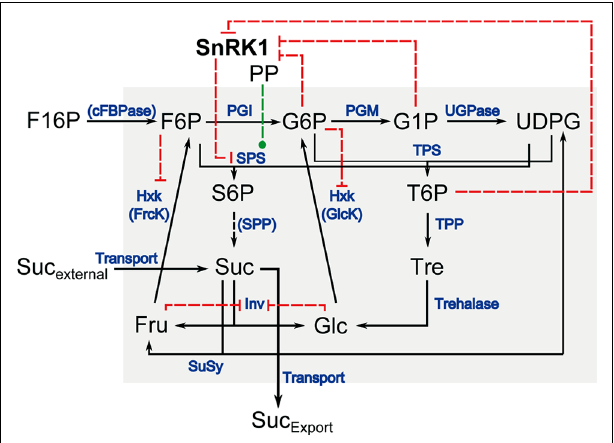
FIGURE 1 | Schematic overview of the cytosolic carbohydrate metabolism in Arabidopsis . Enzymatic interconversions are indicated in black arrows, enzymes that catalyze each step are written in blue. Red dashed lines indicate inhibitory interaction, green dashed lines indicate activation. SnRK1: Snf1-related protein kinase 1; PP: protein phosphatase; F16P: fructose-1,6-bisphosphate; F6P: fructose-6-phosphate; G6P: glucose-6-phosphate; G1P: glucose-1-phosphate; UDPG: uridine-5 (cid:2) -diphosphoglucose; S6P: sucrose-6-phosphate;T6P: trehalose-6-phosphate; Suc: sucrose;Tre: trehalose; Fru: fructose; Glc: glucose; Suc external : externally supplied sucrose; Suc Export : sucrose exported to sinks; cFBPase: cytosolic fructose-1,6-bisphosphatase; PGI: phosphoglucoisomerase; PGM: phosphoglucomutase; UGPase: uridine-5 (cid:2) -diphosphoglucose pyrophosphorylase; SPS: sucrose phosphate synthase;TPS: trehalose phosphate synthase; SPP: sucrose phosphate phosphatase;TPP: trehalose phosphate phosphatase; Hxk: hexokinase; GlcK: glucokinase; FrcK: fructokinase; Inv: invertase; SuSy: sucrose